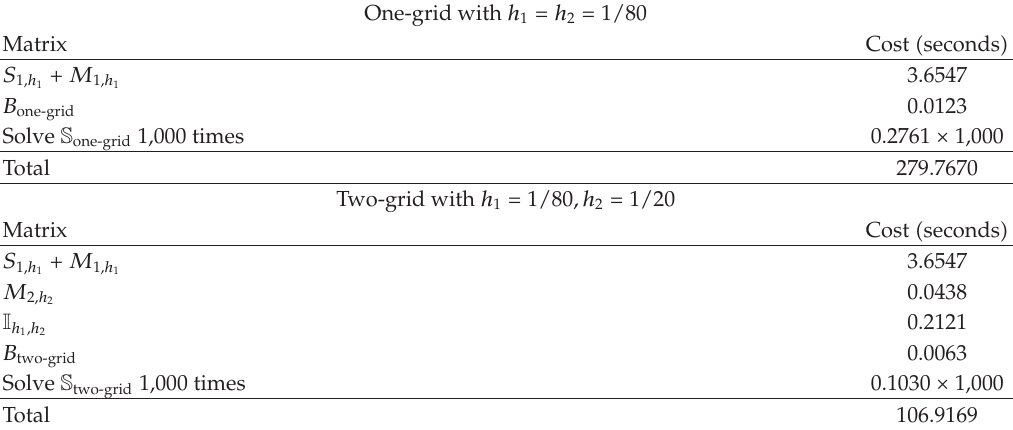
Table 8: Cost of one-grid versus two-grid discretization in a simulation with 1,000 time